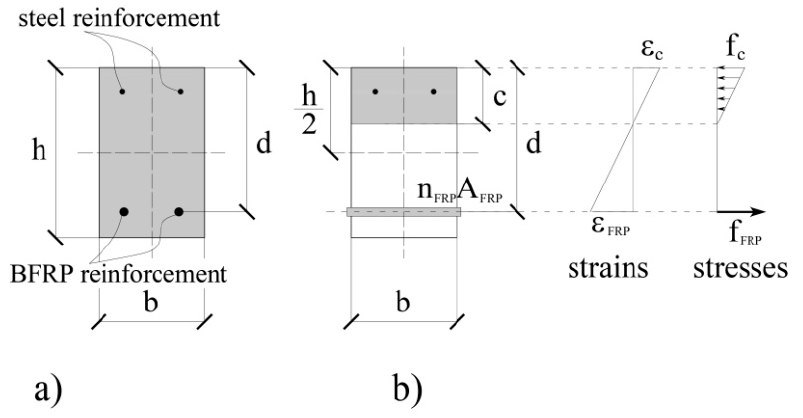
Figure 3. BFRP-reinforced beam: the active concrete cross-section (in grey) before ( a ) and after cracking ( b ); the strain and stress distributions (for the cracked cross-section) are schematized on the right.